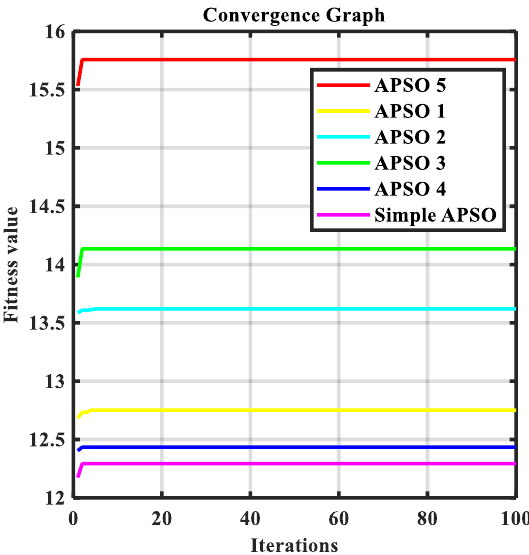
Figure 4. Convergence behavior of the APSO Variant 5 algorithm for 50 PHEVs. Table 4. Comparison of the APSO 5 solution with other algorithm’s solutions in terms of percentage increase for the 50-PHEV dataset. Algorithms Compared with APSO 5